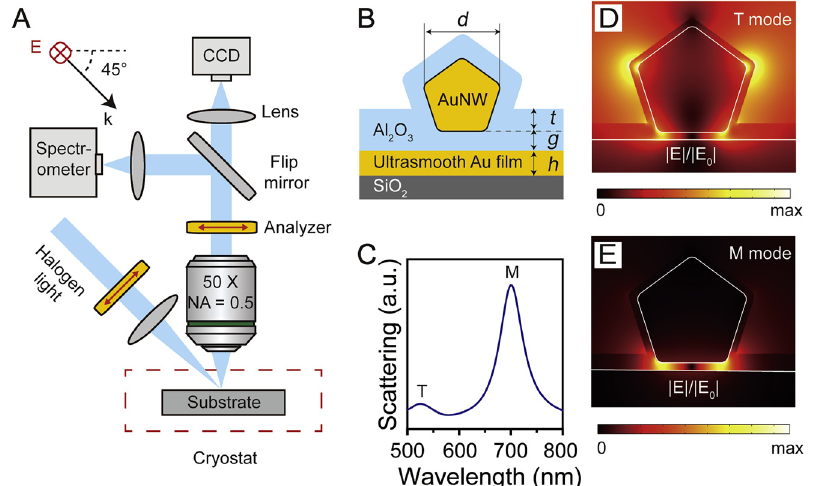
dipole mode of the NW, with the electric fi eld distributions shown in Figure 1D. The M mode ∼ 700 nm originates from